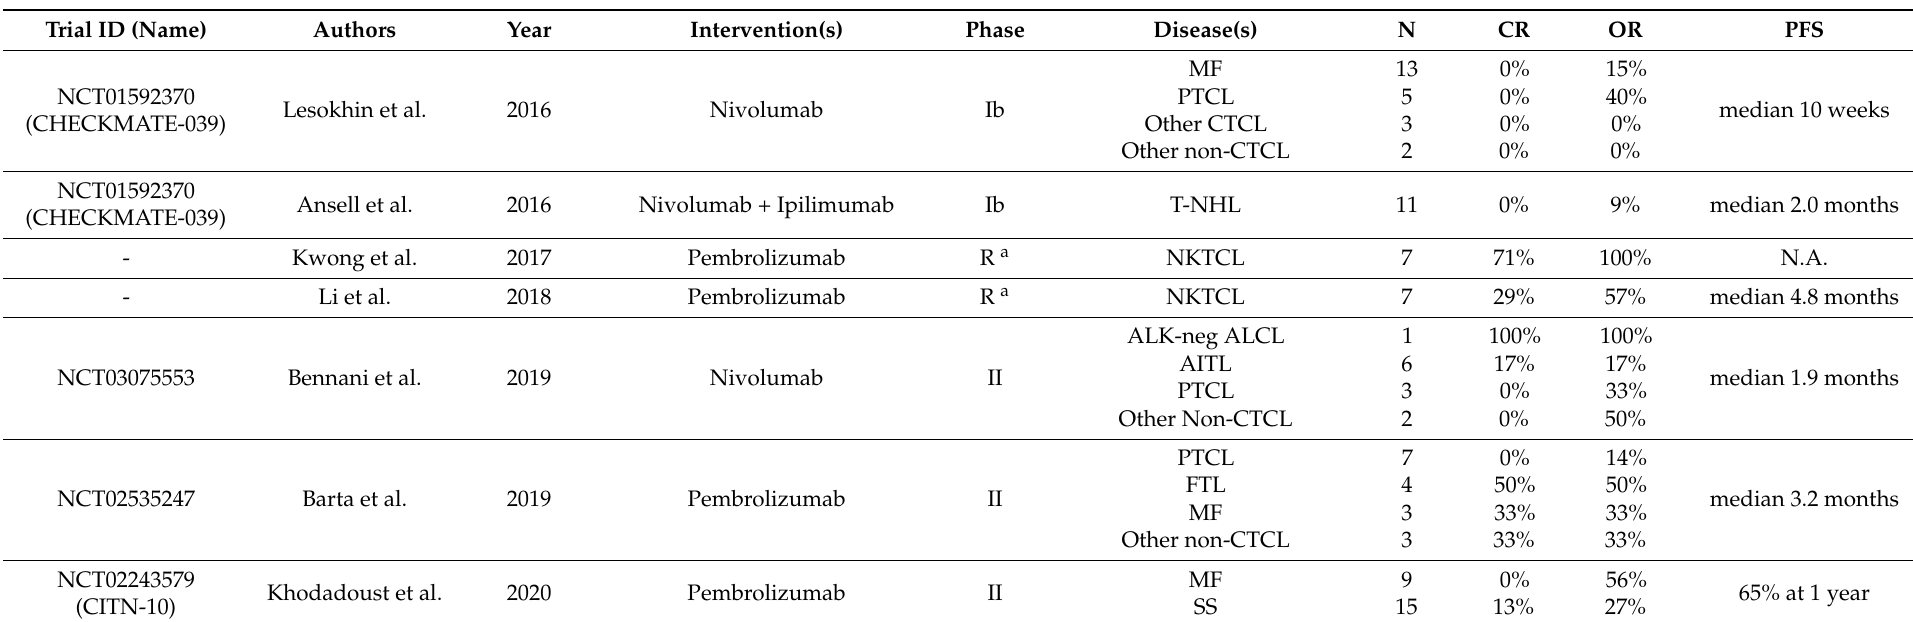
Table 3. Clinical data of immune checkpoint inhibitors in T-cell